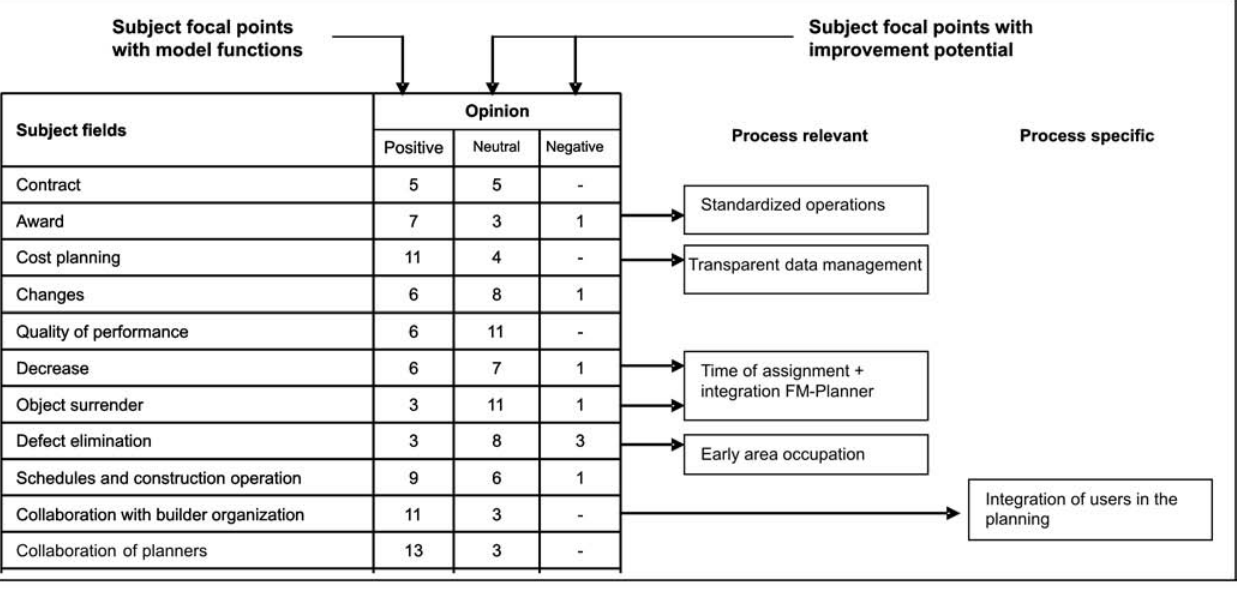
Fig 4. Section from a strengths/weaknesses profile of a large